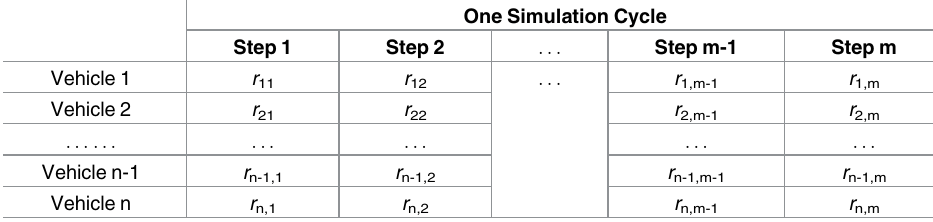
Table 1. Result matrix—vehicle rear-end collision probability on a certain segment in a certain simu- lation